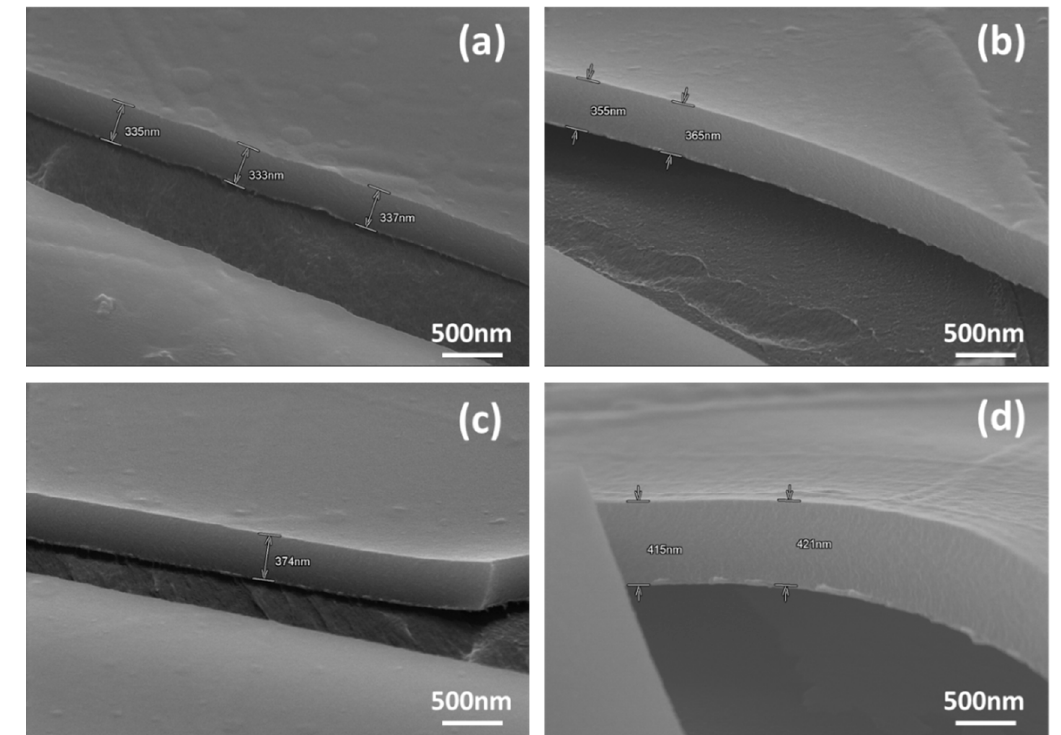
Figure 3. Surface/section morphologies of the siloxane coatings with different thicknesses. ( a ) 335 nm; ( b ) 360 nm; ( c ) 374 nm and ( d ) 418 nm.